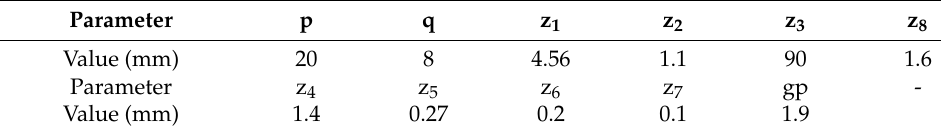
Figure 2. Structure of the four element array antenna. Table 2. Design parameters of four element array